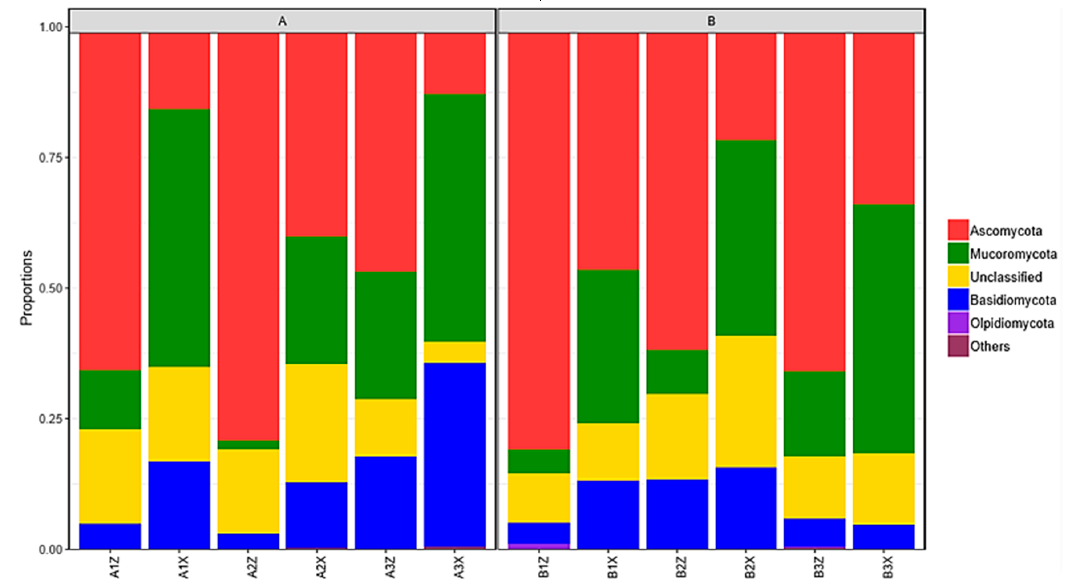
Figure 6. Fungal species structures of plantation forest litter ( A ) and original forest litter ( B ) at the phylum taxonomic level. Microorganisms 2020 , 8 , x FOR PEER REVIEW